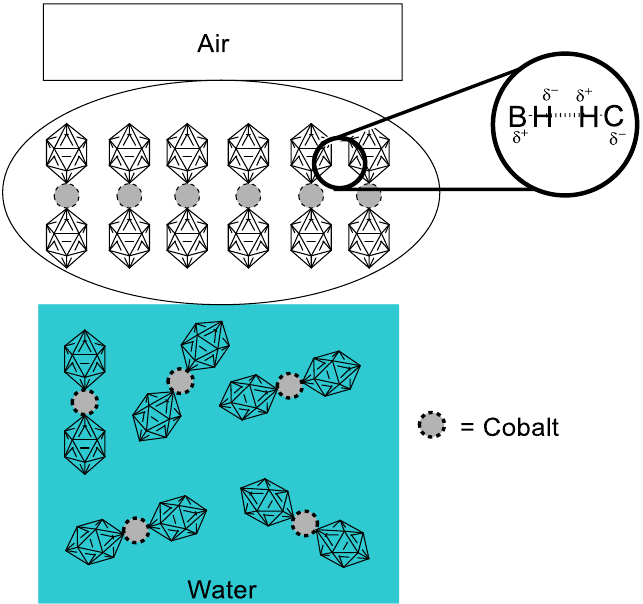
Figure 20. Schematic representation of the interfacial behavior and driving force for supramolecular arrangement of COSAN dimetallacarborane, measured primarily through second-order NLO response.